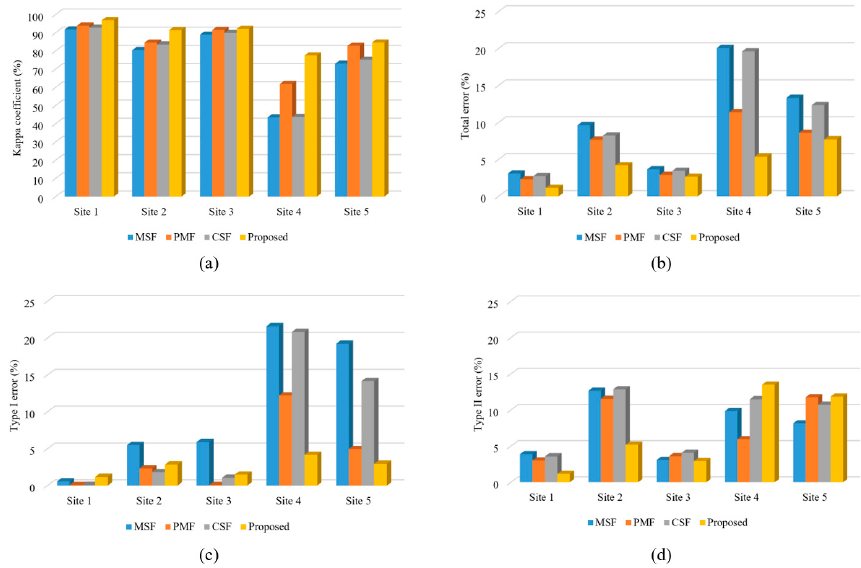
Figure 10. Accuracy assessment of four filtering methods in five forested sites: ( a ) kappa coefficient, ( b ) total error, ( c ) type I error and ( d ) type II error.